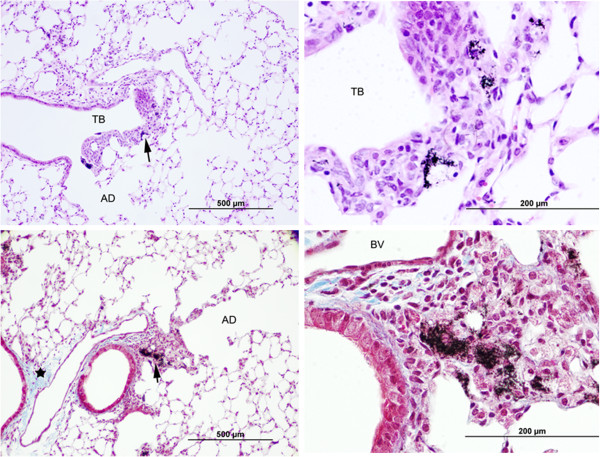
Effect of multi-walled carbon nanotube (MWCNT) inhalation on pulmonary pathology. Images are representative from mice exposed to the high dose (5 mg/m3 for 5 h/d for 19 d) and examined 84 d post-exposure. In the upper panels, MWCNT are within macrophages that have accumulated in connective tissue immediately below the thickened epithelium of the terminal bronchiole (TB). In comparison to the rest of the lung, general fibrosis, as identified by Trichrome staining, was scored as negative in MWCNT-treated mice (lower panels). No significant effects were scored for the middle and low dose exposures. The arrows in the left panels indicate the area of higher magnification shown in the respective right panel.